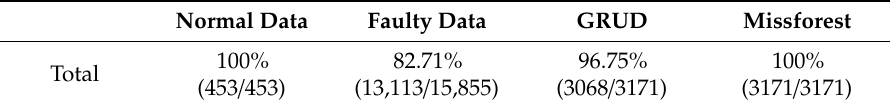
Figure 9. Diagnosis accuracy results of seven sensor errors with error-free data (white), error-injected data (dashed), and the application of GRUD (orange) and Missforest (brown) to the error-injected data. Table 5. Total diagnosis